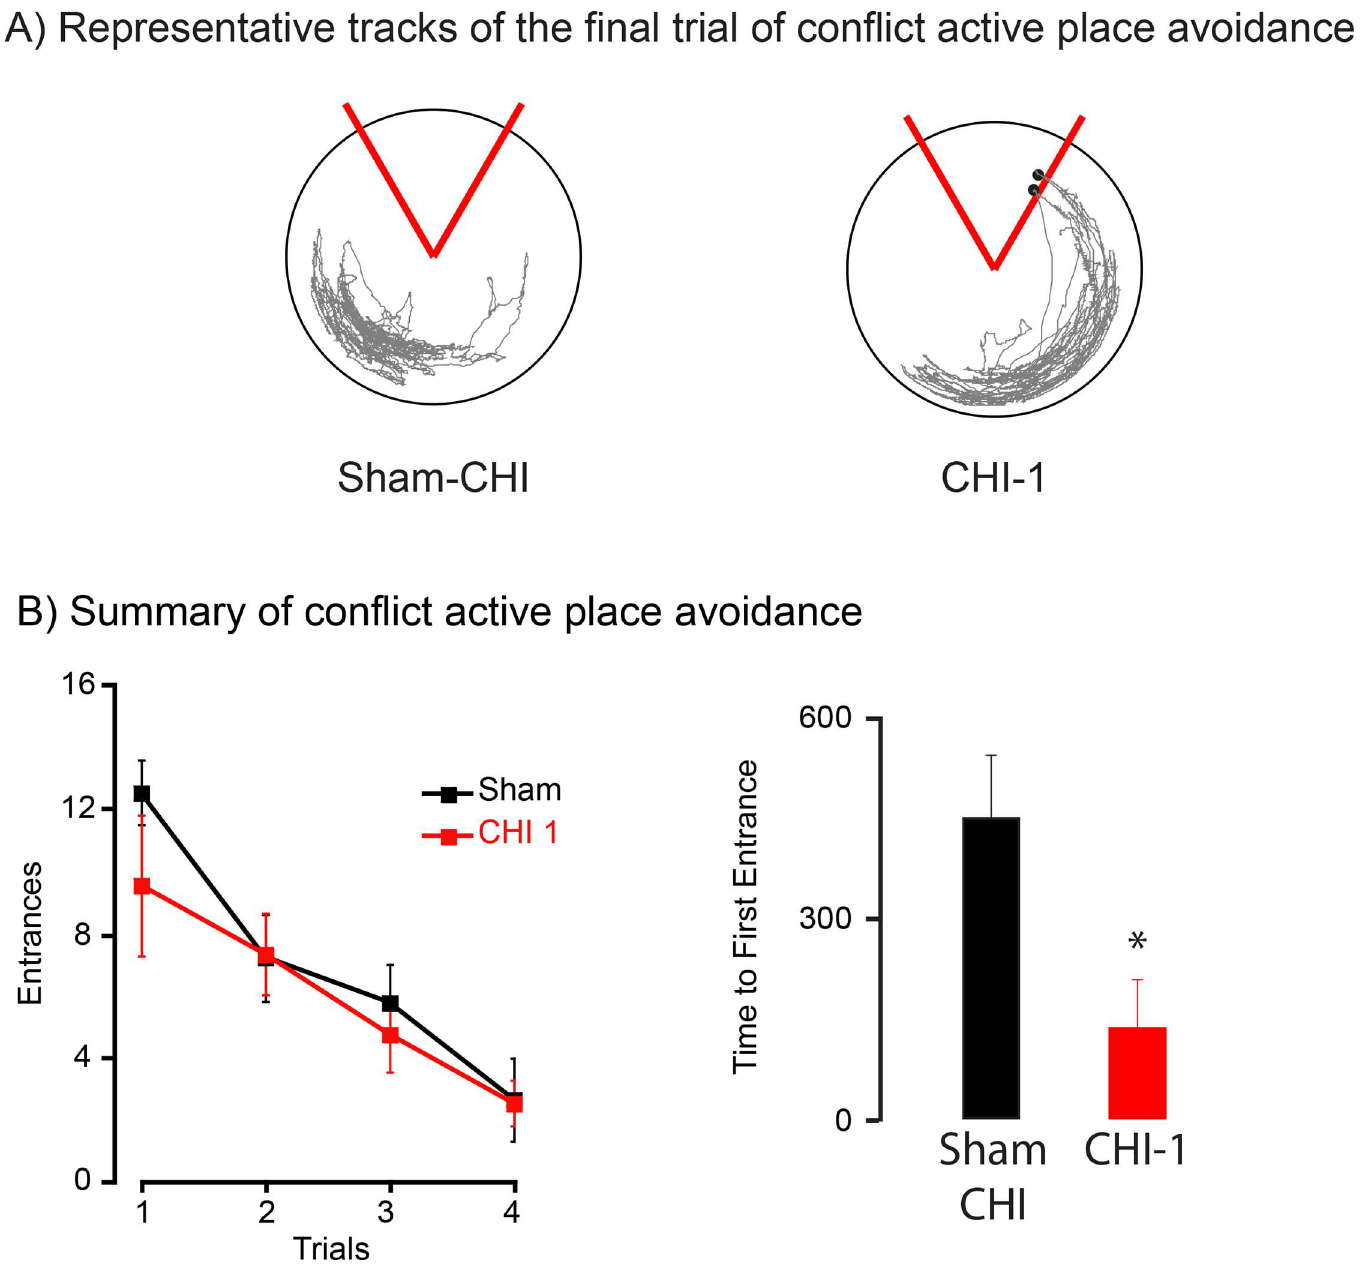
Fig 3. CHI-1 mice acquire, but do not retain, a new shock zone location in conflict active place avoidance. Panel A, Representative tracks from sham-CHI and CHI-1 mice in the final trial of conflict active place avoidance. The 60˚ stationary shock zone is shown in red. Black circles show the location of the mouse when receivinga shock. Panel B, Summary of conflict active place avoidance.On shock zone entrancesduring conflict active place avoidance, group and trial did not significantlyinteract (F 1630,30 = 14.0, p = 0.50). The number of entrancesdid not significantly differ. (F 1,10 = 0.006, p = 0.94).